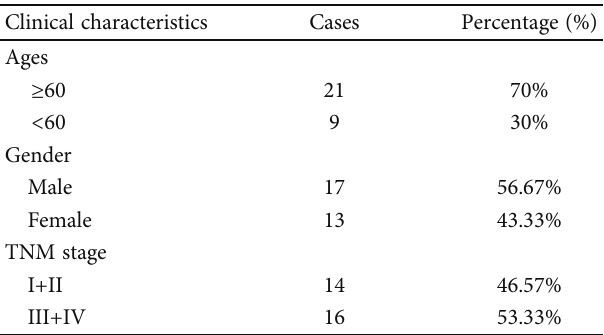
Table 1: Clinical information for patients. Clinical